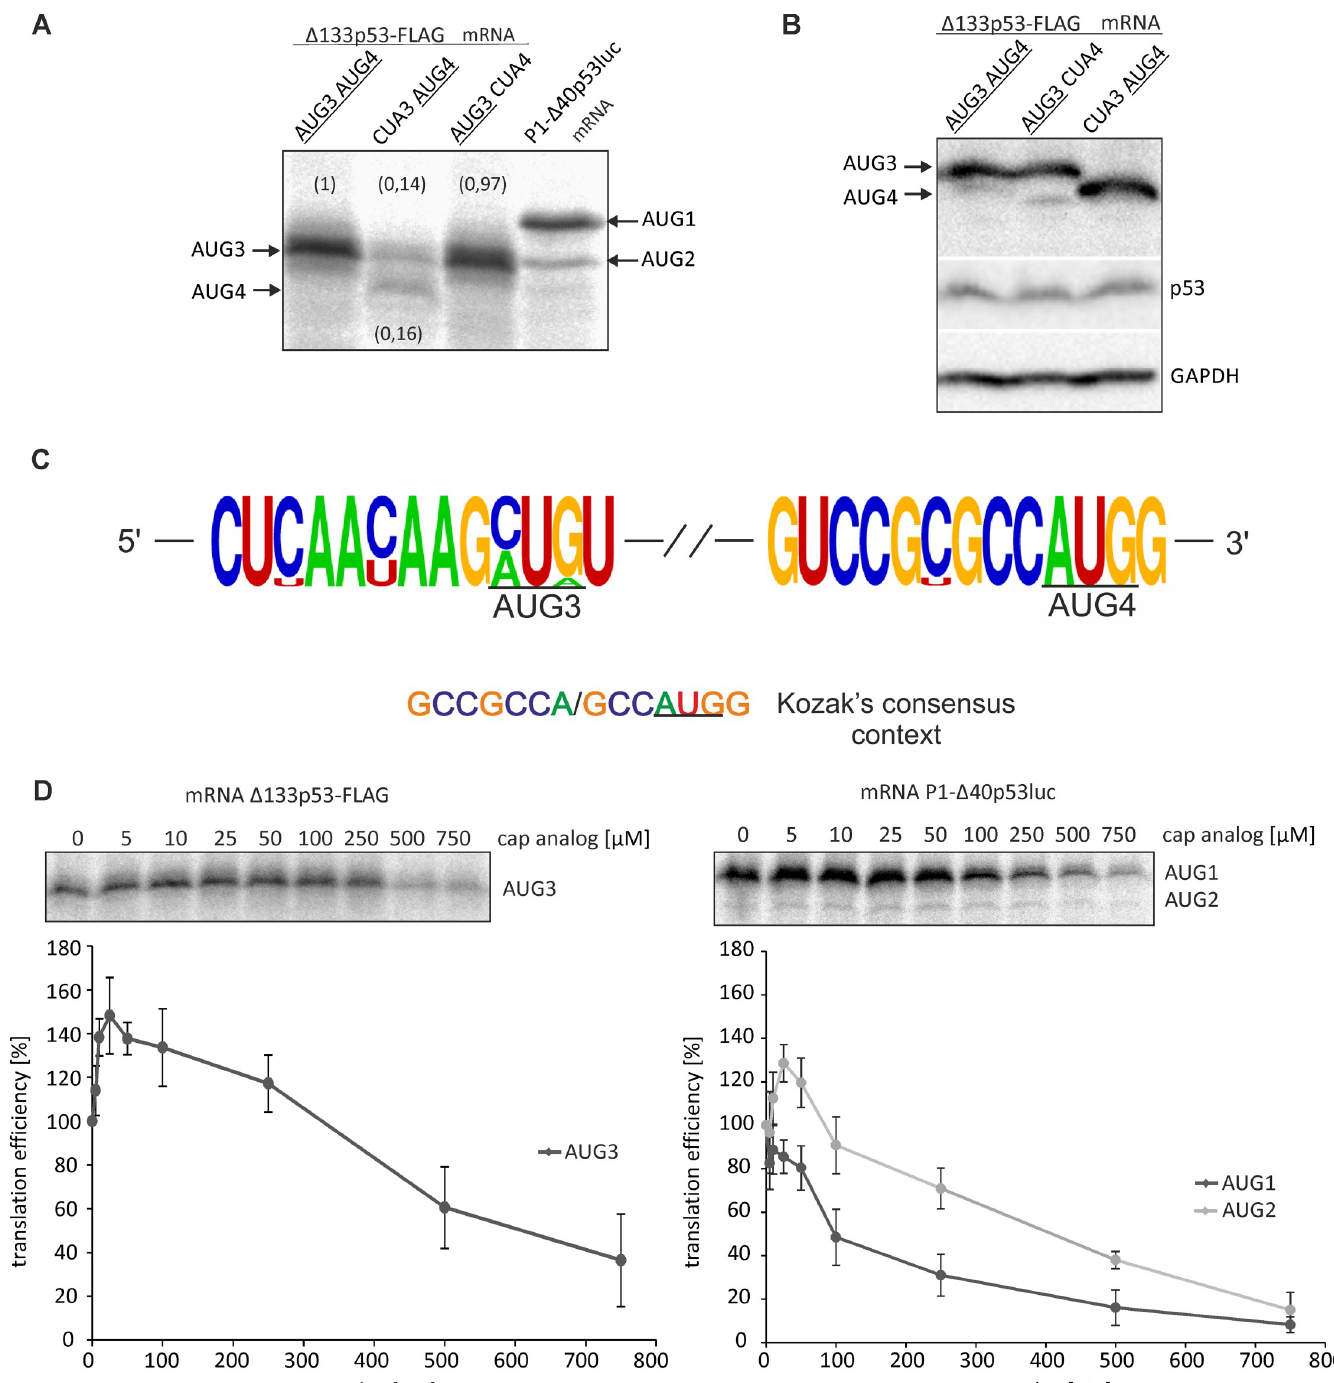
Fig 3. Translation of mRNA constructs from AUG3 and AUG4 initiation codons under in vitro and in cellular conditions. A) Autoradiogram presents translation products of model Δ 133p53-FLAG mRNAs with AUG3 and AUG4 initiation codons or with those codons mutated to triplets CUA3 and CUA4, when translation was performed in rabbit reticulocyte lysate (RRL) with [ 35 S]-methionine. The P1- Δ 40p53luc mRNA construct with AUG1 and AUG2 codons was used in a control reaction. Above and below the bands the relative translation efficiency from AUG3 and AUG4 codons is shown. B) Translation from AUG3 and AUG4 in HCT116 cells transfected with vector-encoded model Δ 133p53-FLAG mRNAs. Western blot shows Δ 133p53-FLAG, p53 and GAPDH levels, C) The Kozak’s context of AUG3 and AUG4 codons in the 5 0 -terminal regions of Δ 133p53 mRNA sequences derived from ten different species shown in Fig 2D) The capped mRNA variants were translated in RRL in the presence of an increasing concentration of the cap analogue (m 7 GpppG) to inhibit cap-dependent translation. The amounts of protein products resulting